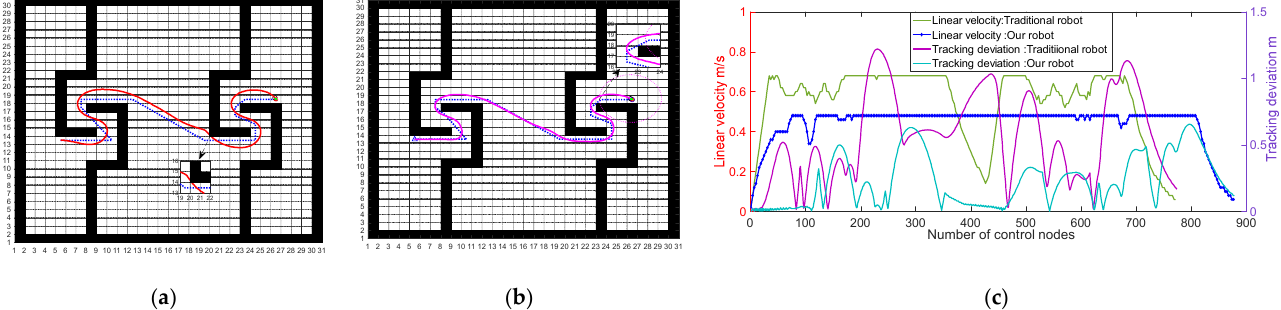
Figure 18. Map 5’s experimental results. ( a ) Traditional robot. ( b ) Our robot. ( c ) Two-coordinate plot of linear velocity and tracking deviation.